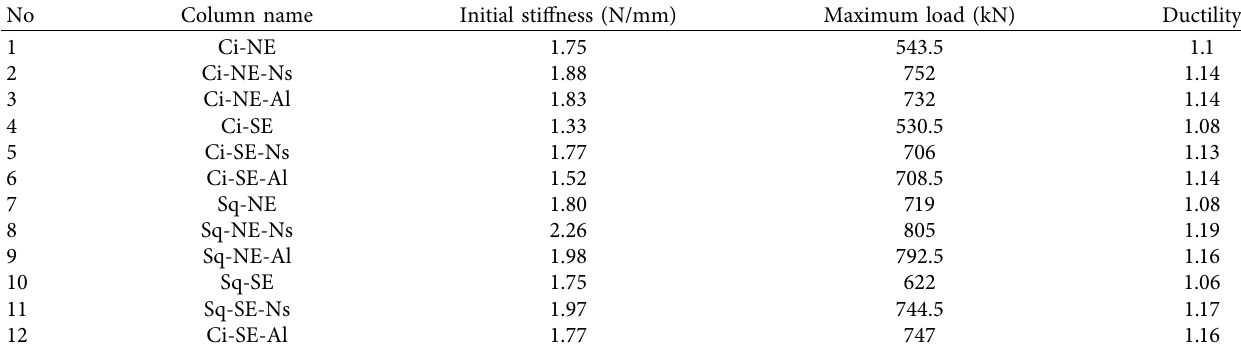
Table 6: Te results of strengthening the columns.